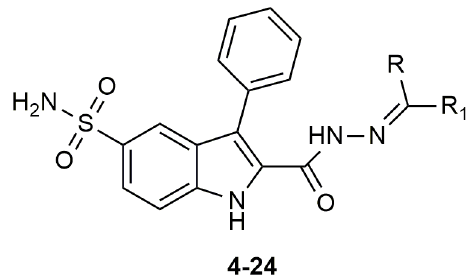
Figure 5. The molecular structure of compounds 4 – 24. Table 1. Inhibition data against human (h) isoforms hCA I, II (cytosolic), and bacterial enzyme VcCA of derivatives 4 – 24 and azm by a stopped-flow CO 2 hydrase assay.